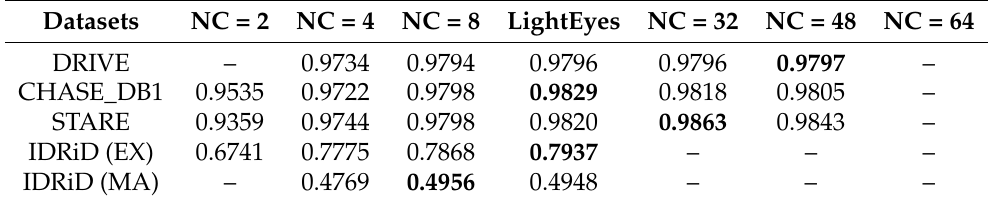
Table 12. Segmentation results when varying the number of filters in LightEyes (NC denotes the number of convolutional filters per convolution layer in the backbone of the LightEyes, and we use AUC/F1-score to evaluate vessel/lesion segmentation maps). Best results are bold.